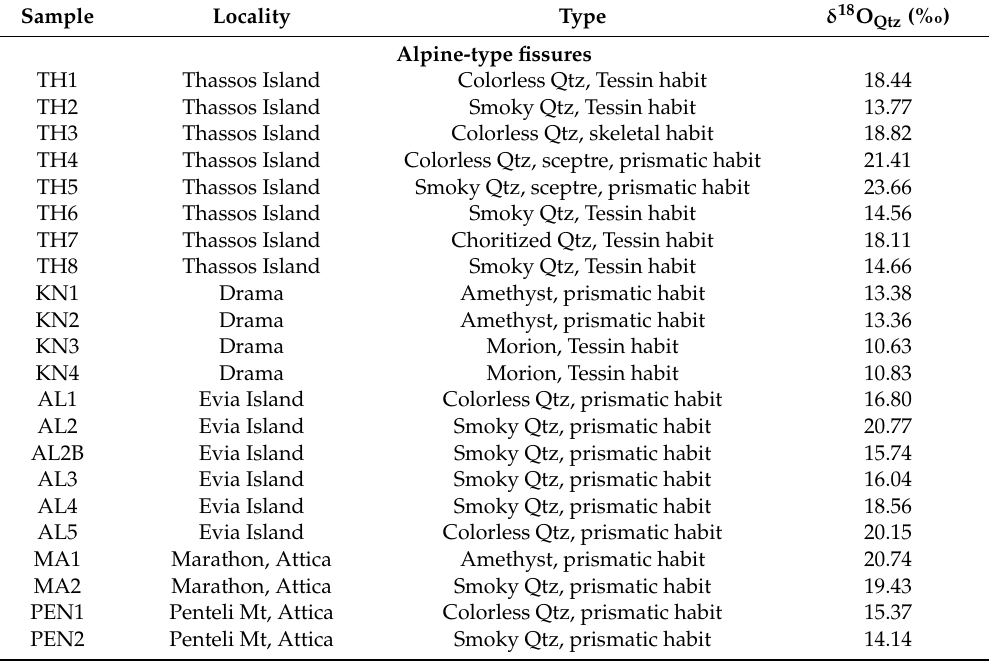
Table 3. Oxygen isotope composition of quartz from various geological settings in Greece ( δ values in ‰ relative to SMOW).